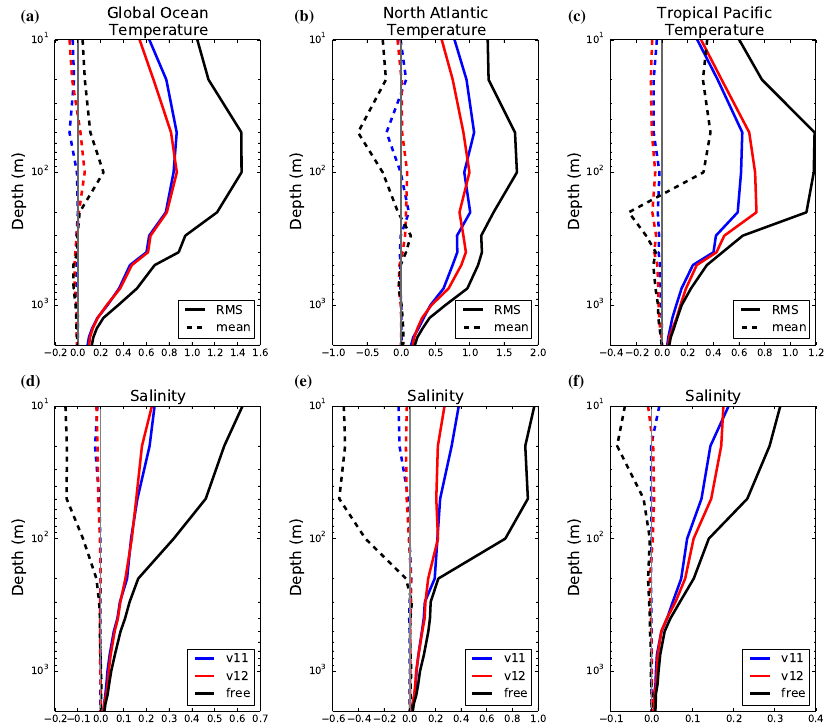
Figure 3. Mean error profiles against EN3 data for temperature (top row; ◦ C) and salinity (bottom row; measured on the practical salinity Fig.3. MeanerrorprofilesagainstEN3datafortemperature(toprow; ◦ C )andsalinity(bottomrow;measuredonthepracticalsalinityscale) scale) plotted against model depth (m) on a log scale for the global ocean (left), North Atlantic (centre) and tropical Pacific (right) regions. plotted against model depth ( m ) on a log scale for the Global Ocean (left), North Atlantic (centre) and Tropical Pacific (right) regions. Solid Solid lines denote rms errors and dashed lines denote mean errors for the v12 (red), v11 (blue) and free (black) trials. Mean errors are plotted lines denote RMS errors and dashed lines denote mean errors for the v12 (red), v11 (blue) and free (black) trials. Mean errors are plotted as modelled-observed meaning that positive temperature (salinity) values indicate that the model is too warm (salty). as modelled–observed, meaning that positive temperature (salinity) values indicate that the model is too warm (salty). imate increase of 28cm globally over the course of the 2- are approximately 80% of the RMS error. For these reasons 795 year trial period (not shown). This SSH drift appears to be SSH mean errors are not included in Fig. 2. Table 3. Percentage reduction in rms error for the v12 trial rela- the result of a mis-match between the precipitation and river- tive to the v11 trial calculated separately for areas of high and low ine freshwater inputs and is most likely the result of a pre- 785 mesoscale variability in the extratropics from 23 to 66 ◦ latitude. The cipitation bias in the NWP forcing fields. This ties in with variability threshold used is based on the standard deviation of SLA the aforementioned surface salinity drifts seen in Fig. 3 and Fig. 2d. It is worth noting that a 2 year drift of 28cm cor- observations with σ = 0 . 11m. The proportion of the extratropical responds to a daily drift of approximately 0 . 4mm which ocean surface classified as either high or low variability using this is unlikely to have an adverse effect on the quality of the 790 threshold can be seen in the bottom row of the table. short-range FOAM forecasts. Mean errors for the assimila- tive models are typically less than 5 mm and, globally, are less than 5% of the RMS error. Meanwhile for the free run theSSHdriftcausesmeanerrorsofaround20 cm –25 cm that